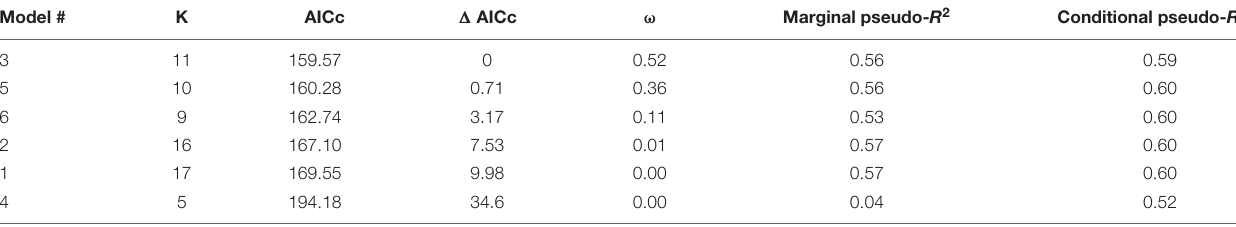
Models are sorted from high to low weight and K denotes for the number of estimable parameters, AICc for the second-order variant of Akaike’s Information Criterion, (cid:49) AICc for AICc difference, ω for Akaike weight, and marginal/conditional pseudo-R 2 represent the variance explained by the fixed effects only and by the entire model, respectively.